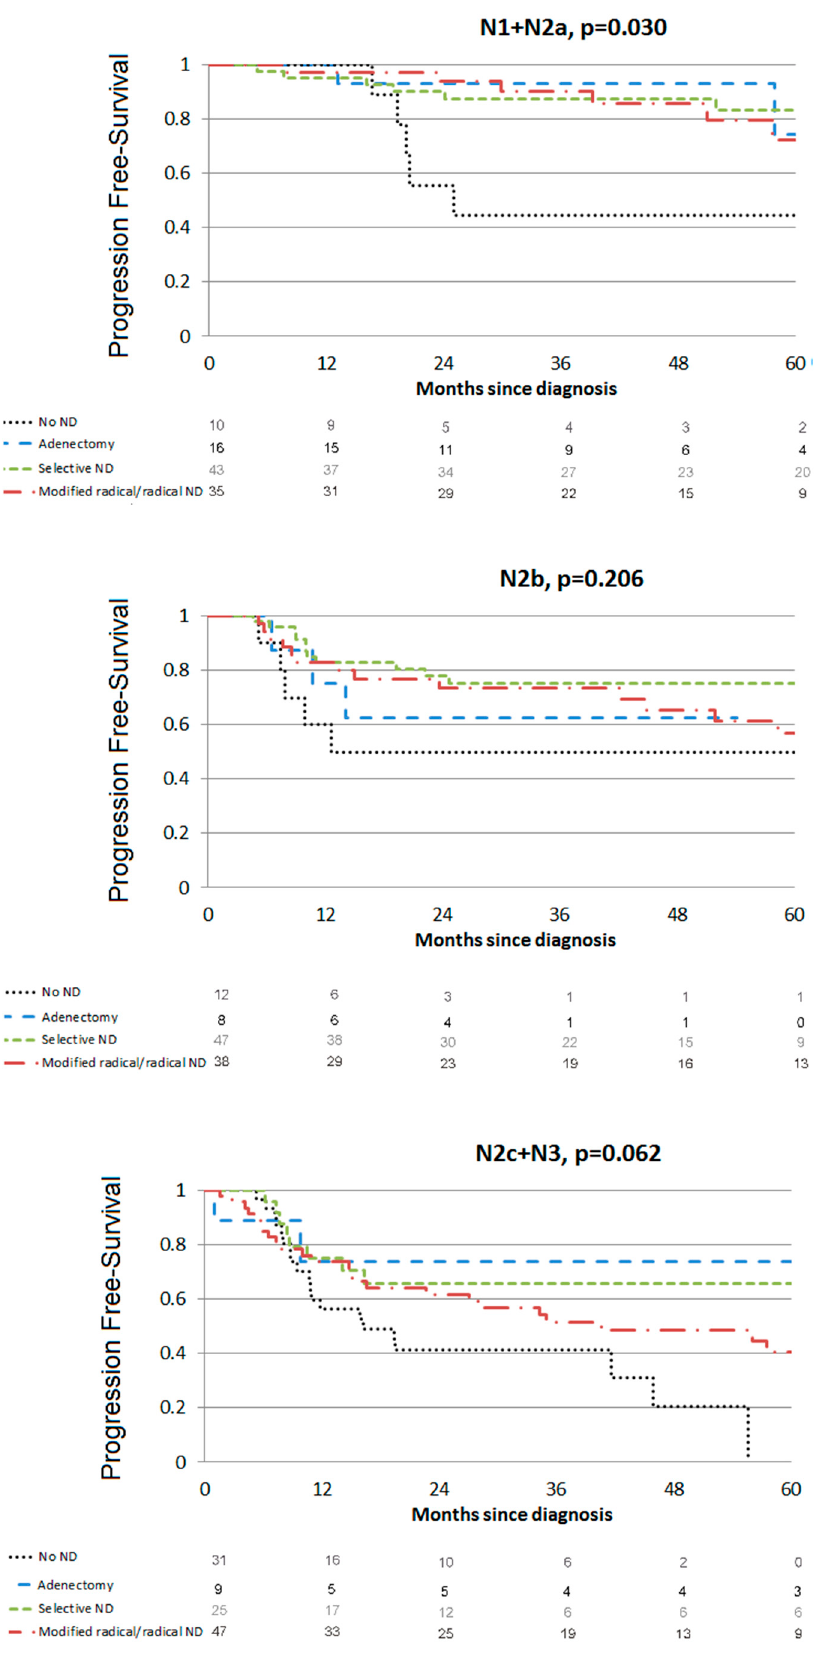
Figure 2. Progression-free survival.